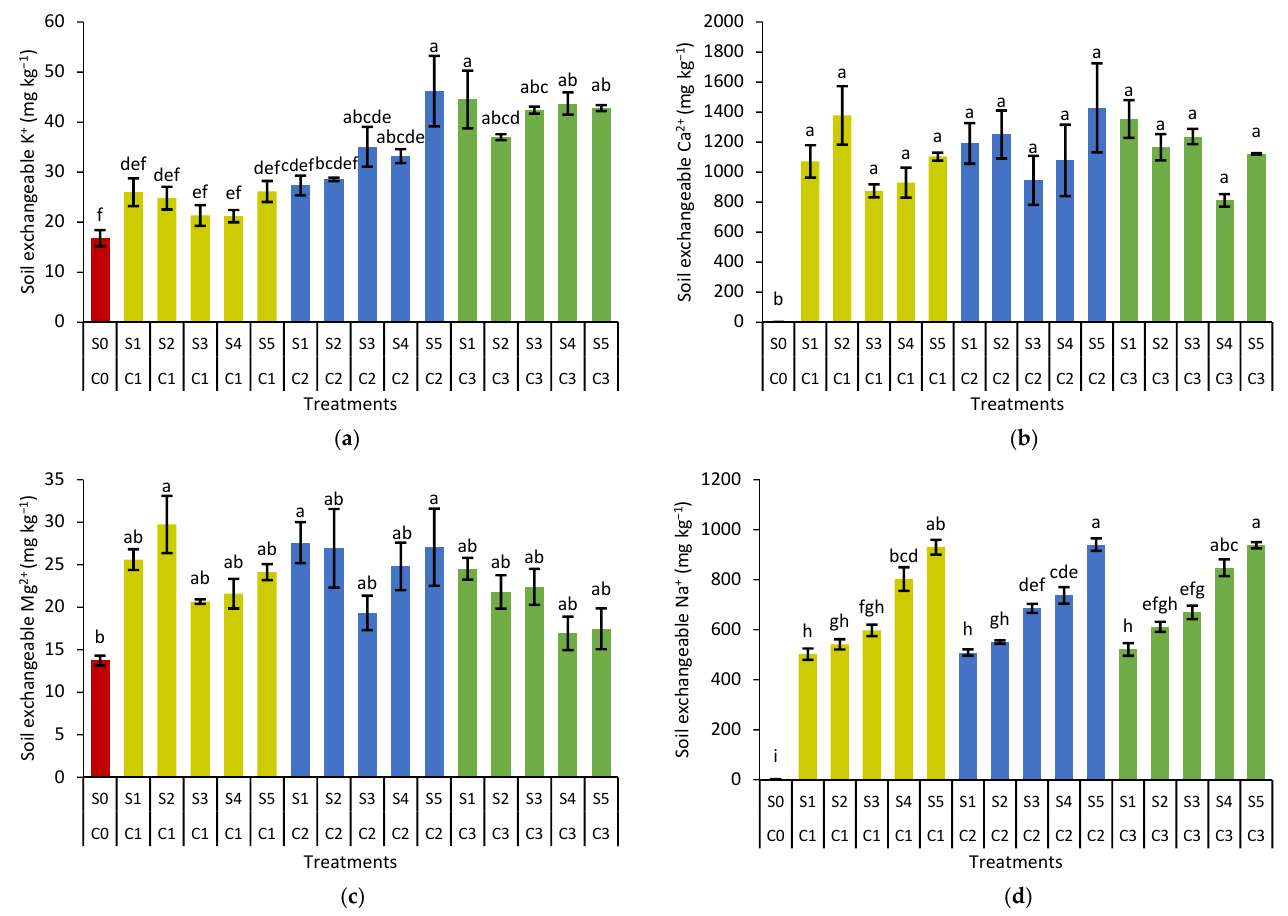
Figure 10. Soil exchangeable ( a ) potassium, ( b ) calcium, ( c ) magnesium, and ( d ) sodium for the different treatments after thirty days of leaching. Different letters indicate significant mean differences using Tukey’s HSD test at p ≤ 0.05. Error bars represent the standard error of the mean.